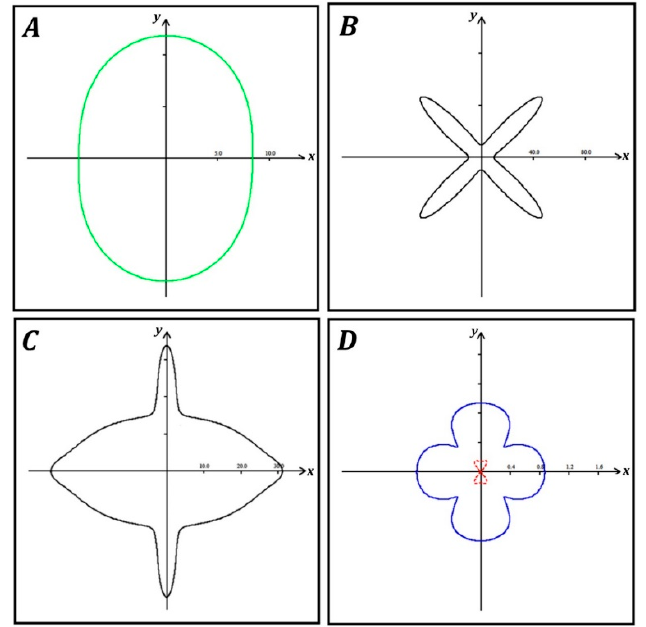
Figure 3. Two-dimensional projections on the xy plane of the tridimensional representations of the elastic properties of copper squarate as a function of the orientation of the applied stress: ( A ) Com- pressibility; ( B ) Young modulus; ( C ) Maximum shear modulus; ( D ) Maximum (blue) and minimum (red) Poisson’s ratios. The labels of the marks in the vertical axis are exactly the same as those of the horizontal one. In the plots, negative values are displayed in red.